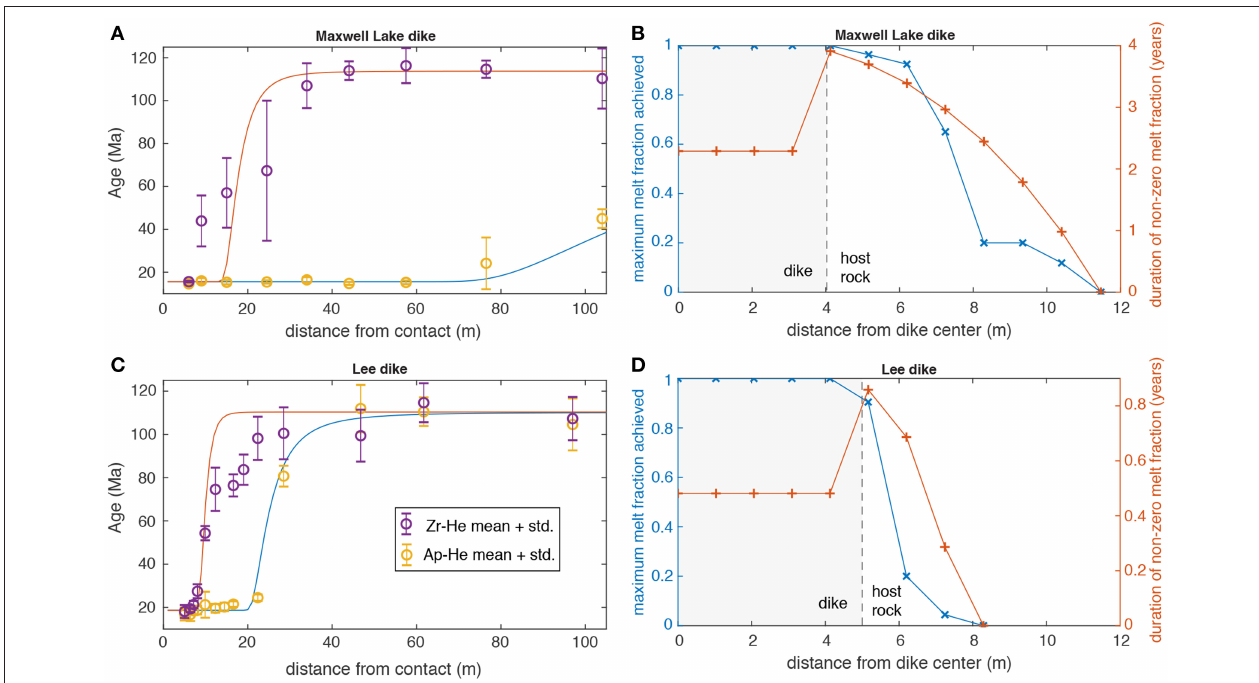
FIGURE 11 | Example fits of Maxwell Lake and Lee dike thermochronology data, plotting curves associated with the median of MCMC-derived PDFs ( Table 1 ) for both zircon (red curves) and apatite (blue curves) ages. (A,C) show the predicted thermochronometric ages for each dike, using average ages plotted in Figure 2 . (B,D) plot the predicted maximum melt fraction and duration of non-zero melt fraction as a function of distance from the dike center associated with these model runs (dike material is shaded gray, while symbols indicate non-uniformly spaced grid nodes). Duration of partial melt in host rock can exceed the active lifetime of the dikes due to lower solidus of tonalite relative to basalt.